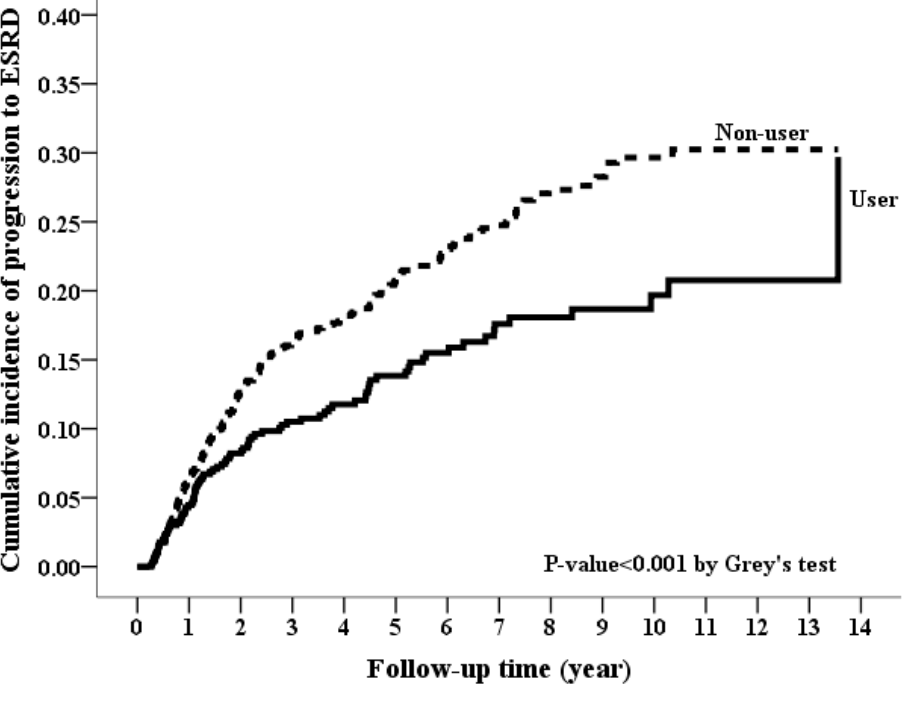
Figure 2. Cumulative incidence rate of progression to end-stage renal disease between spironolactone users and non-users. ( p -value < 0.001, Grey’s test).